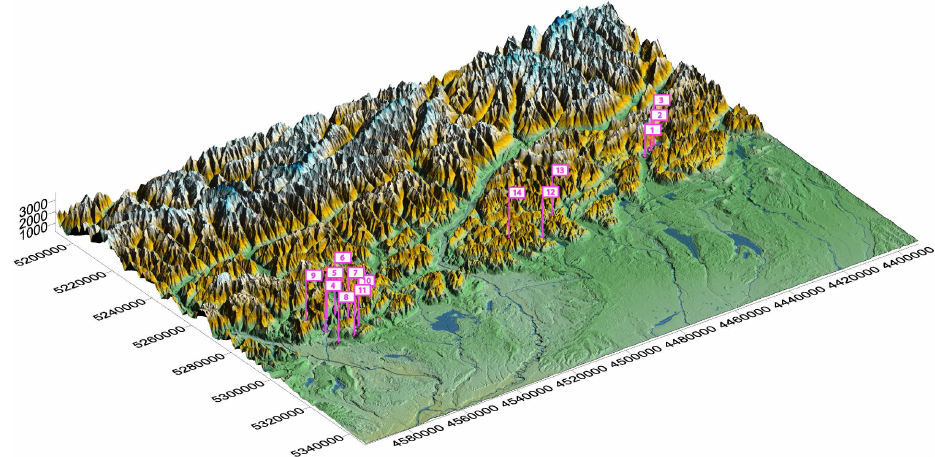
Fig. 2. Alpine region showing the location of observation stations used in this paper: 1 Garmisch-Partenkirchen, 2 Grainau, 3 Grainau (Eibsee), 4 Bad Reichenhall, 5 Schneizlreuth-Unterjettenberg, 6 Schneizlreuth-Ristfeucht, 7 Schneizlreuth-Weissbach, 8 Anger-Oberh¨ogl, 9 Bischofswiesen-Winkl, 10 Inzell, 11 Anger-Stoissberg, 12 Rottach-Egern, 13 Kreuth, and 14 Schwarzkopfh¨utte.